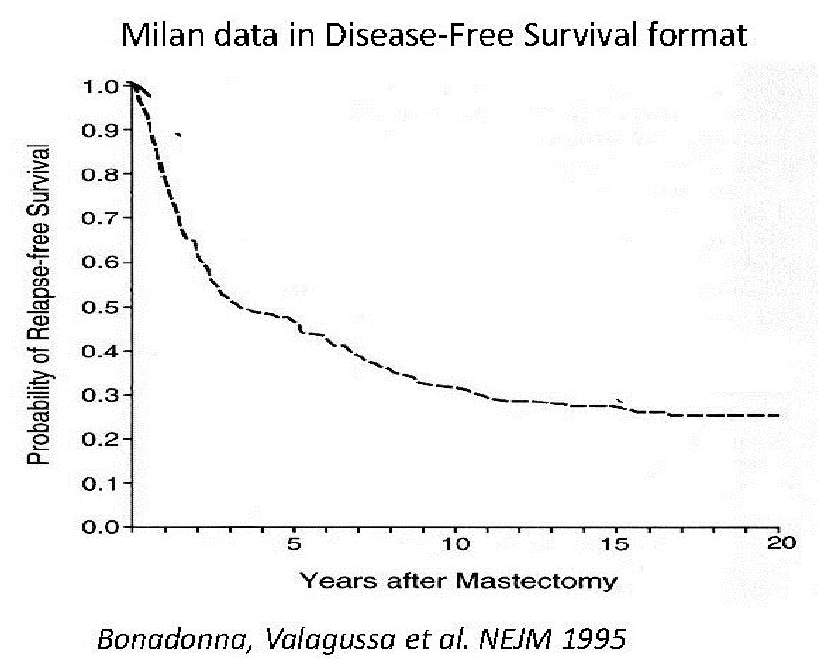
Figure 2. Milan data in disease-free survival format for premenopausal patients. Modified from Bonadonna et al. [3].